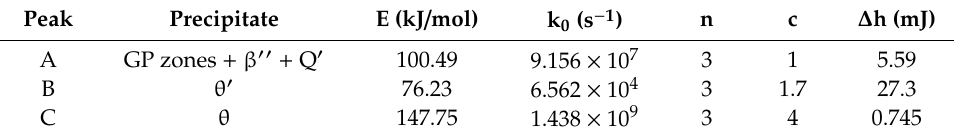
Figure 5. DSC run and peaks (A, B, C) adjusted to optimize the fit between experimental and sum of the heat produced by associated transformations for AlSi7Cu3.5Mg0.15 (Mn, Zr, V) alloy. Table 3. Parameters from the fitting procedure for AlSi7Cu3.5Mg0.15 (Mn, Zr, V) alloy. Peak